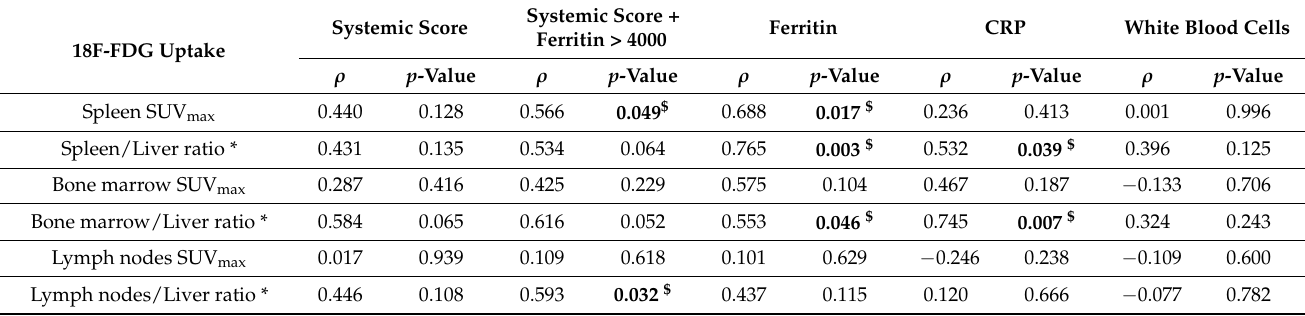
Table 4. Correlation between 18F-FDG uptake and clinical and biological disease